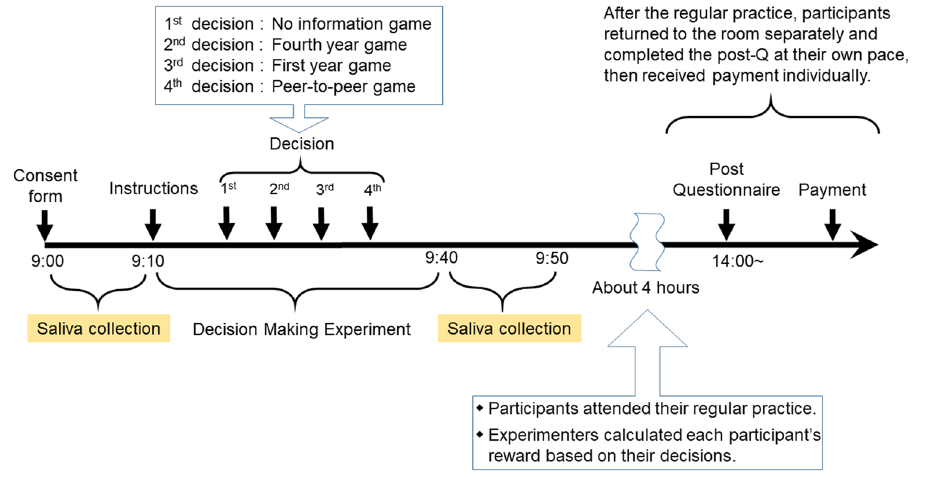
Figure 1. A summary of the experimental